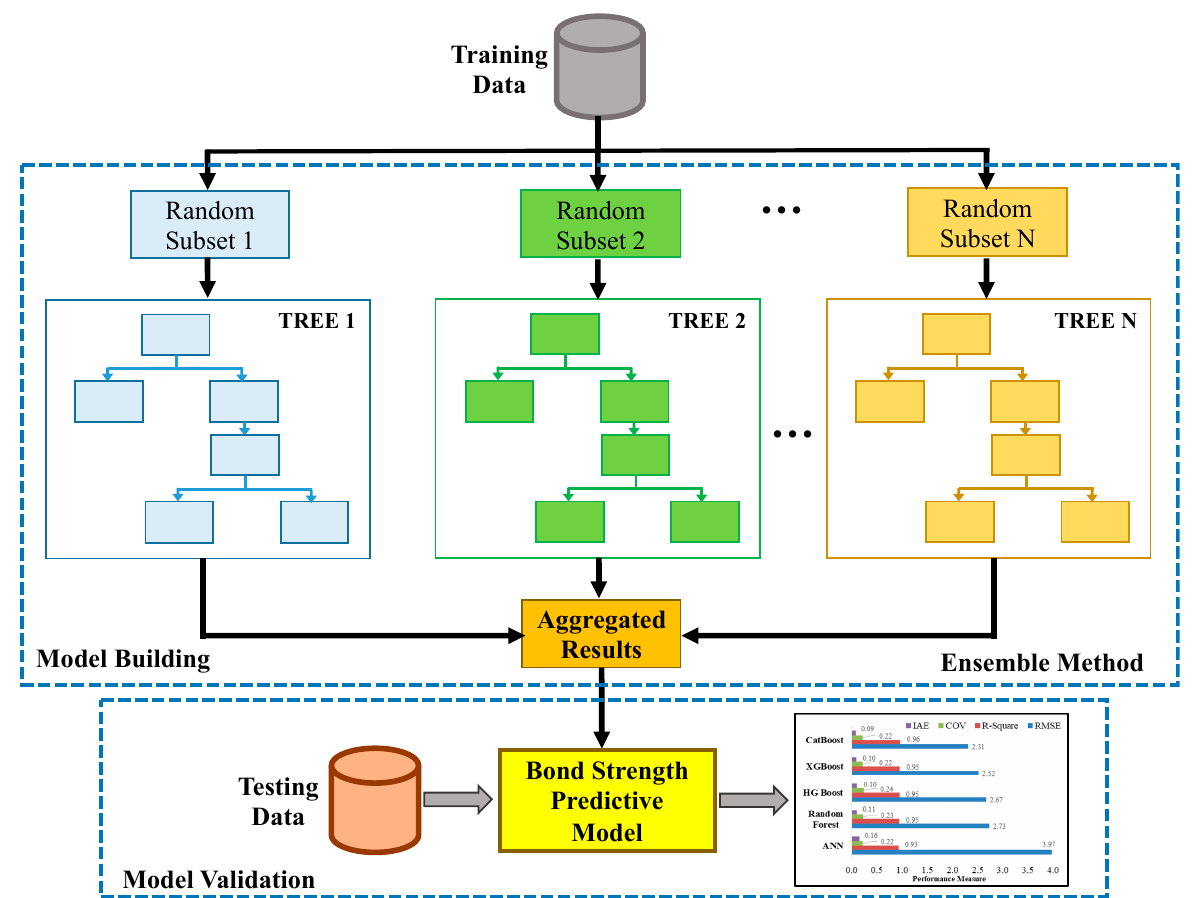
Figure 2. Ensemble classifier-based bond strength prediction model.